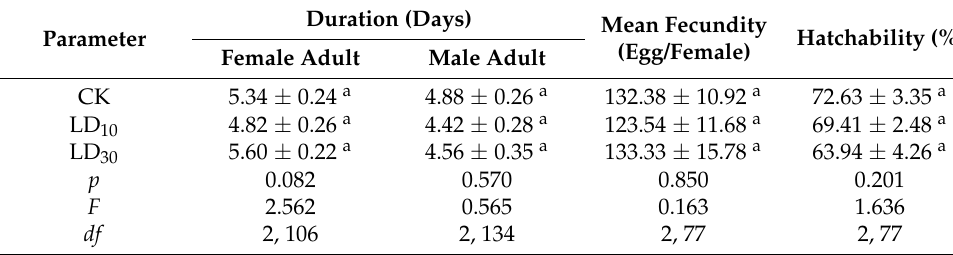
Table 8. Sublethal effect of fluxametamide on duration, mean fecundity, and hatchability of F 1 C. suppressalis